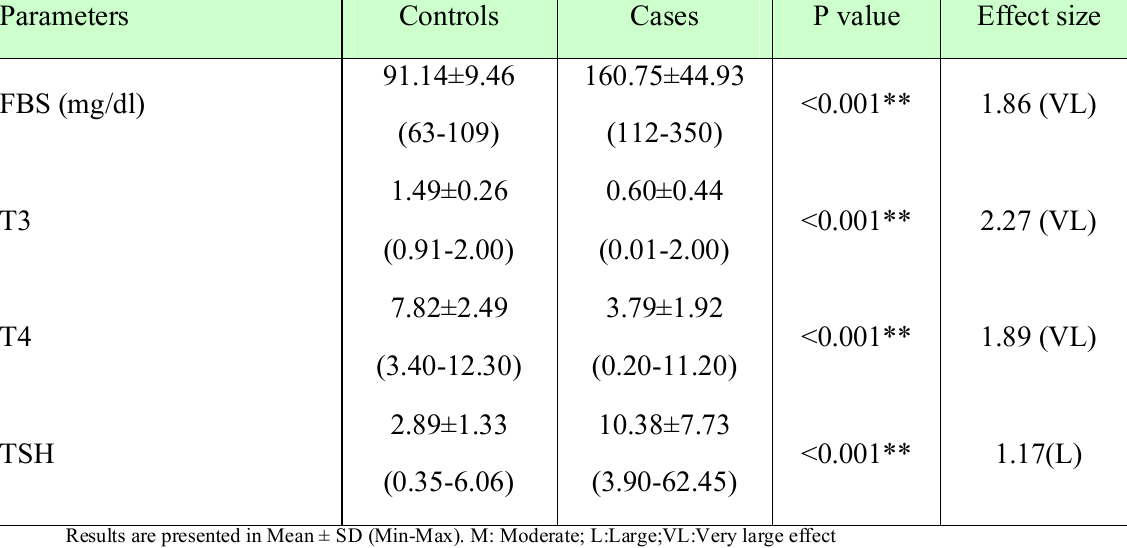
Table 3: Comparison of levels of sugar and thyroid parameters